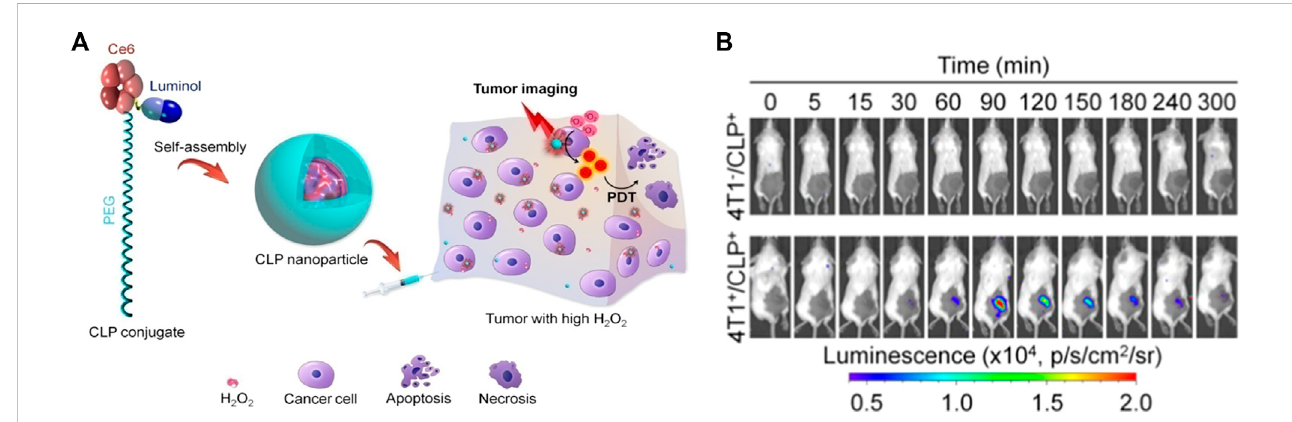
FIGURE 1 (A) Schematic illustration of CL imaging of tumors with high H 2 O 2 and H 2 O 2 -mediated photodynamic therapy using CLP nanoparticles. (B) Time- dependent in vivo CL imaging of healthy mice and 4T1 tumor-bearing mice after local injection of CLP nanoparticles (An et al.,